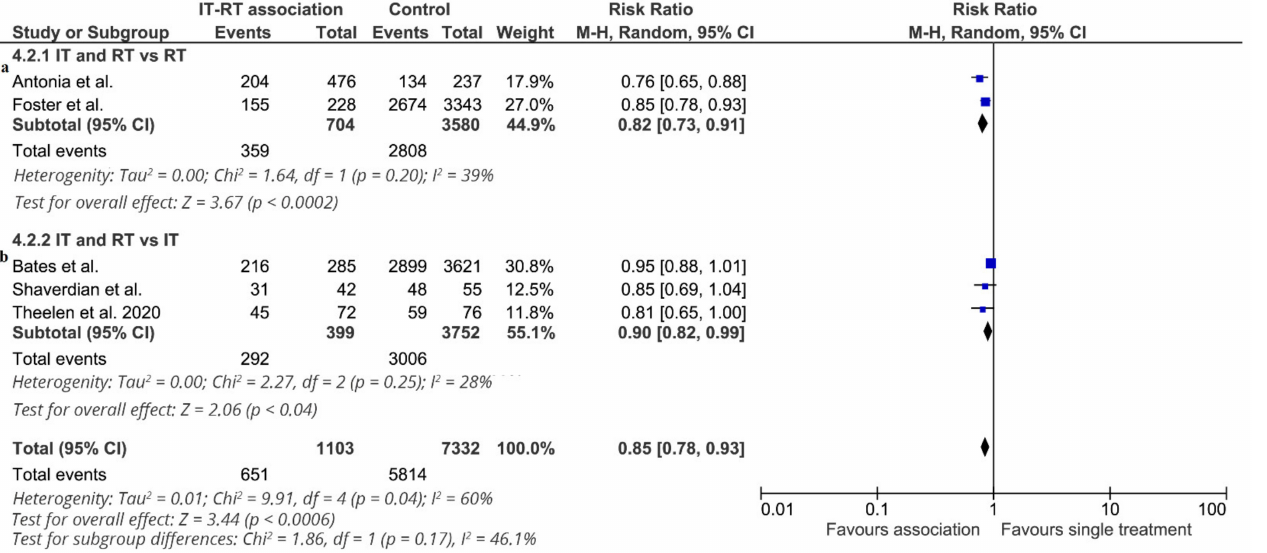
Figure 3. 3-year overall survival. Meta-analysis of 5 studies of ICI-RT association: 2 studies of ICI-RT vs. RT alone ( a ) and 3 studies of ICI-RT vs. ICI alone ( b ). The risk ratio (RR) and 95% confidence interval (CI) for the effect of treatment on 3-year overall survival are shown on a logarithmic scale. Studies are arranged by publication year. Theelen study is a pooled analysis of two